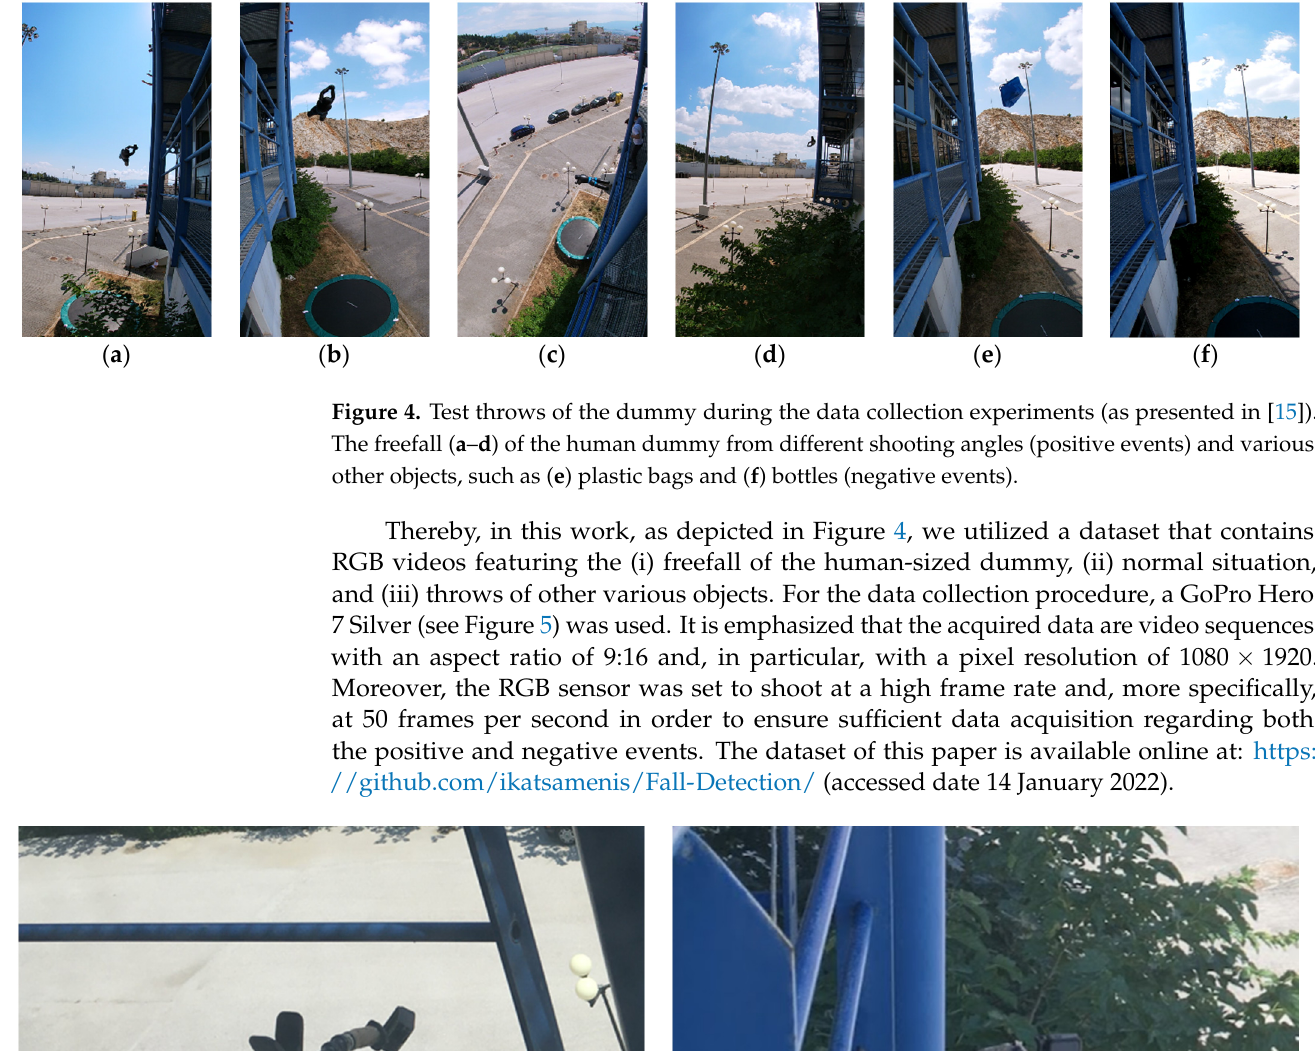
6 of 18 Figure 2. Structure of the individual autoencoders. 4. Experimental Evaluation 4.1. Dataset Description To train and evaluate the proposed methodology, a mock man overboard event was conducted that concerned the fall of a human-sized dummy from the balcony of a high- rise building. In particular, the human dummy (see Figure 3), weighting 30 kg, was thrown from an approximate height of 20 m, which is roughly equivalent to two seconds of free-falling. Figure 3. The human-sized dummy that was used during the test throws. As depicted in Figure 4a–d, for the purposes of the specific experiment, we per-